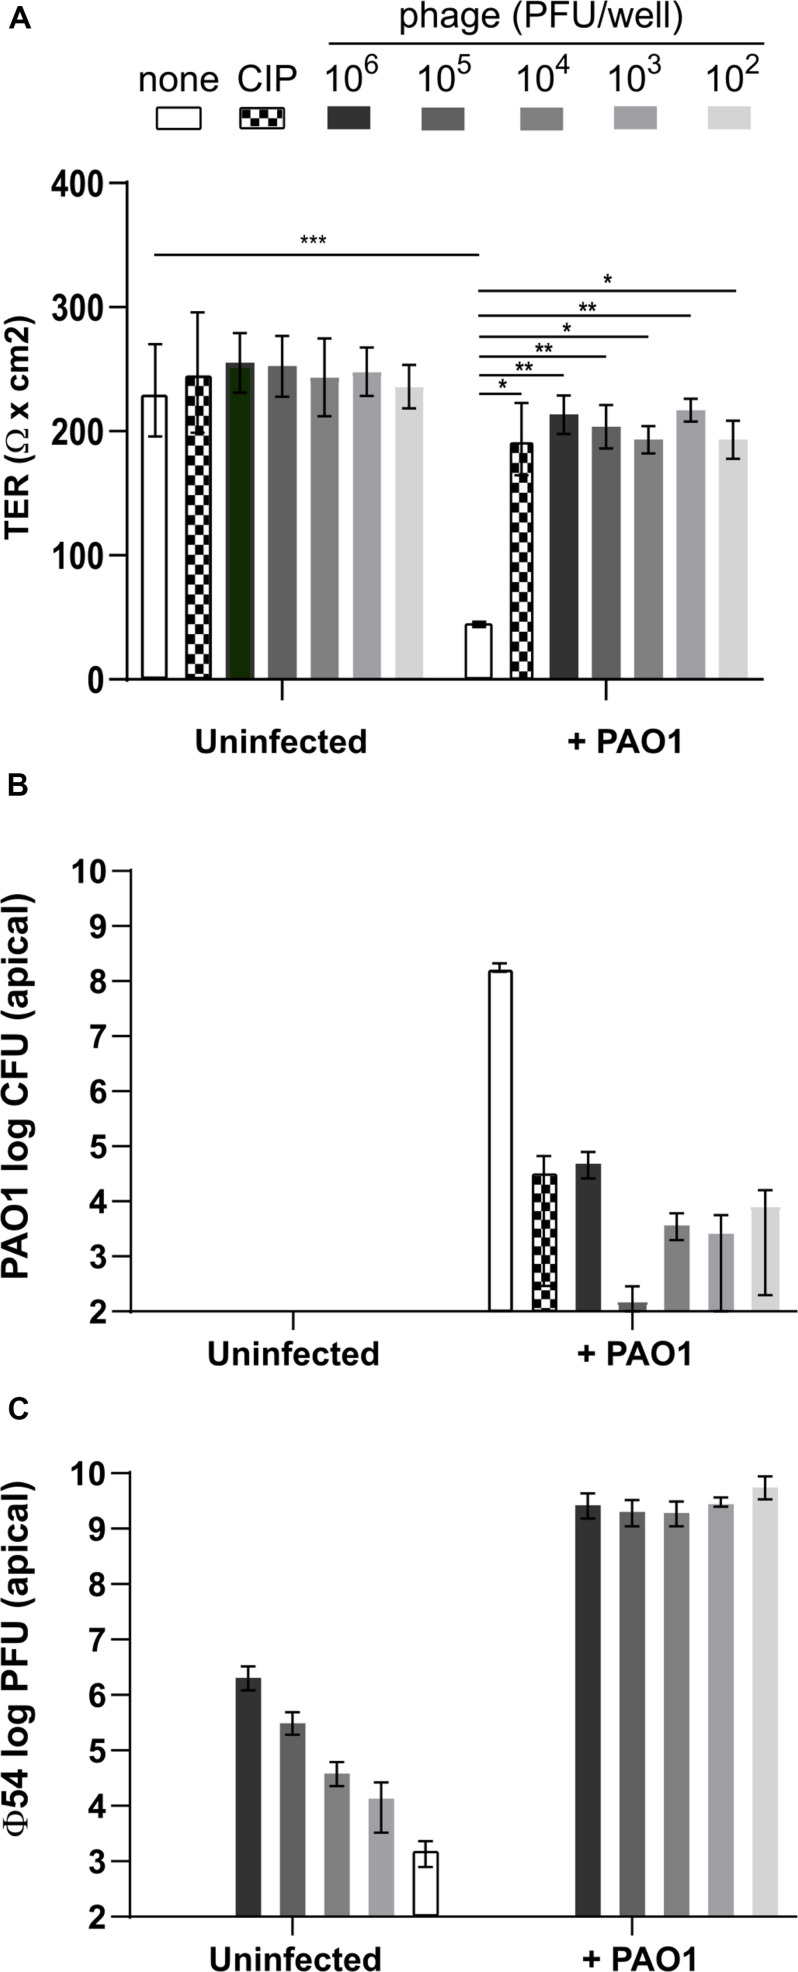
Measurement of trans-epithelial resistance (TER), CFU and PFU at 24 h of Calu-3 cells infected with P. aeruginosa PAO1 and treated with ϕ54. (A) Phages alone do not affect TER and remain infective for 24 h. Cell integrity is maintained by ciprofloxacin (CIP) treatment (4 mg/ml) or addition of phage at an initial inoculum of 102 to 106 PFU/well. (B) Treatment with CIP or phage reduces PAO1 counts after 24 h. (C) In the absence of PAO1, phage titers remain constant during 24 h. In the presence of PAO1, phage replicate to the same titer independent of the initial inoculum. Values represent median and range of three independently performed experiments. Differences in TER between the conditions were assessed using a one-way ANOVA; *p < 0.05, **p < 0.01, ***p < 0.005.